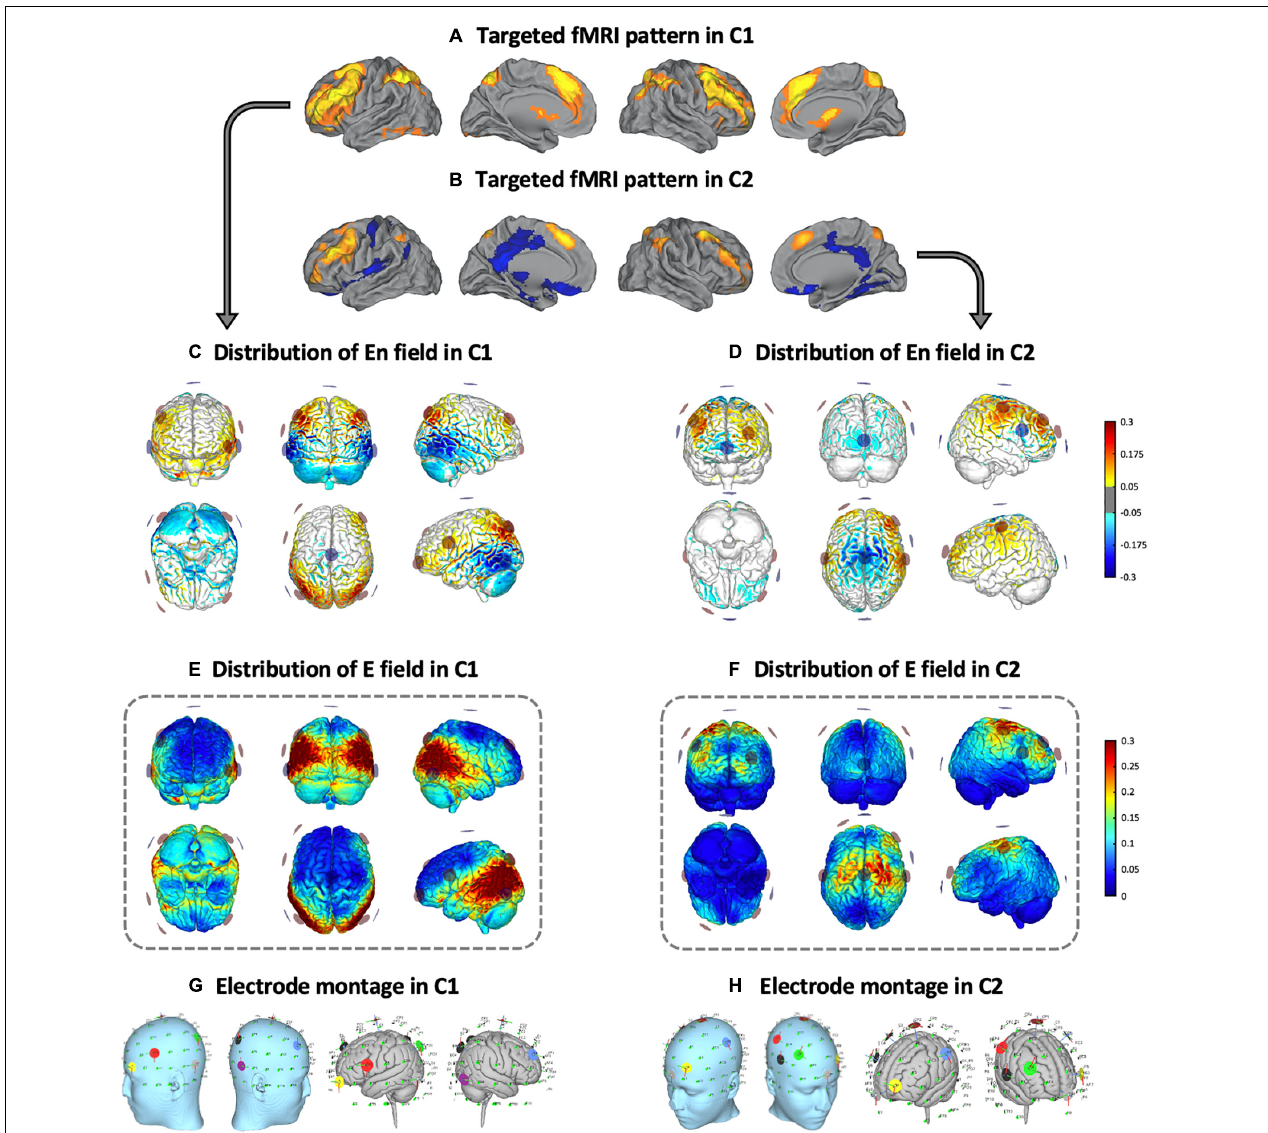
FIGURE 2 | Multifocal tDCS montages. Targeted fMRI patterns in (A) C1 and (B) C2, from Fernández-Cabello et al. (2016, adapted with permission). Distribution of the E n field in the cortical surface in (C) C1 and (D) C2 (in V/m units). Distribution of the electric field’s magnitude in the cortical surface in (E) C1 and (F) C2 (in V/m units). Representation of the electrode locations and shape on the scalp (left) and the gray matter (right) based on a Montreal Neurological Institute (MNI) head in (G) C1 and (H) C2, obtained for visual purposes. fMRI, functional magnetic resonance imaging; C1, condition 1; C2, condition 2.